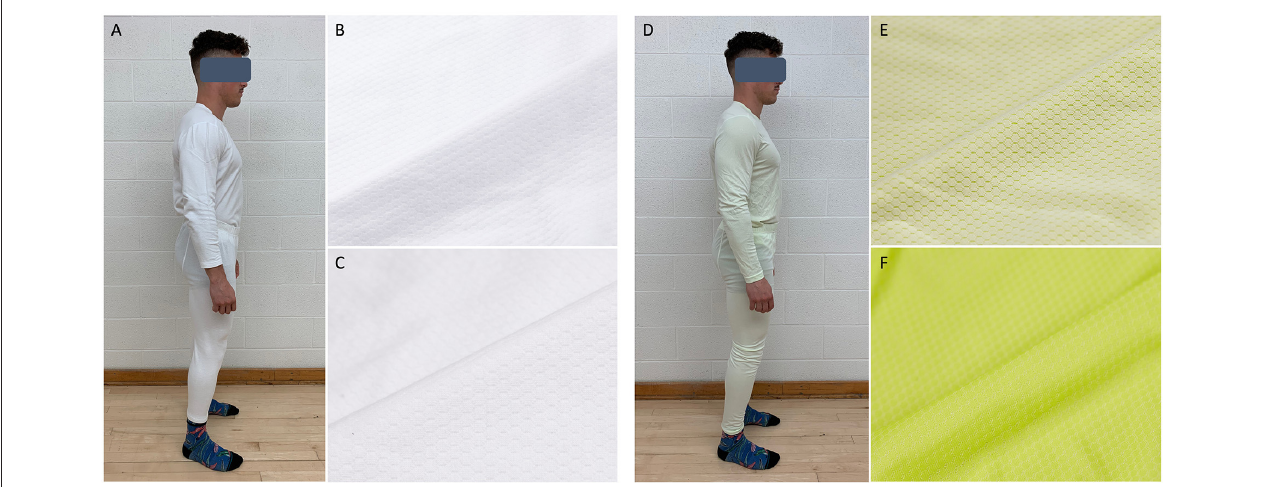
FIGURE 1 | Clothing ensembles. (A) 100% cotton fabric (CTN) clothing ensemble (shirt and pants). (B) CTN macroscopic structure (face side). (C) CTN macroscopic structure (skin side). (D) nylon-polyester synthetic fabric (SYN) clothing enemble. (E) SYN macroscopic structure (face side) includes channeled polyester to help spread moisture across the surface, designed to promote quicker evaporation. (F) SYN macroscopic structure (skin side) includes a flat channel nylon with elements extruded in the yarn to promote cooling effect.